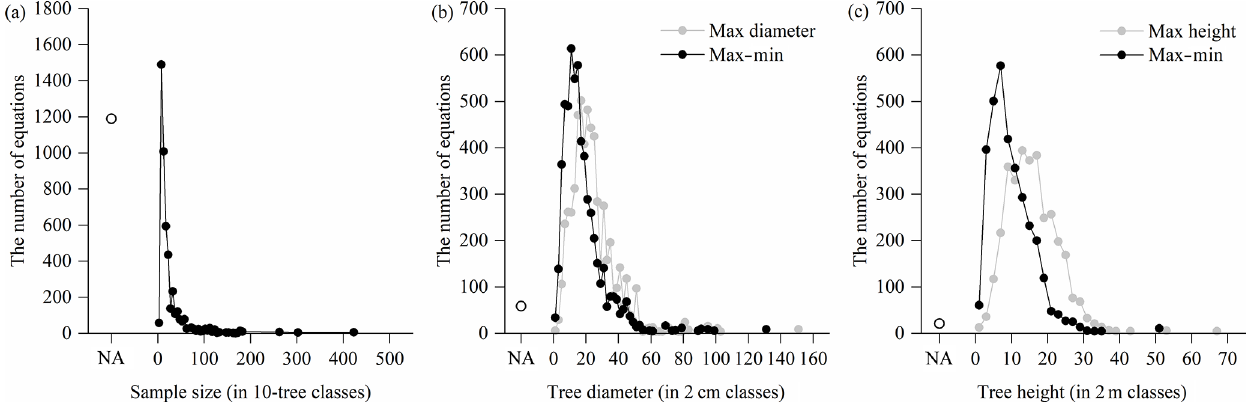
Figure 5. Distribution of sample size and applicable range of compiled biomass equations: (a) sample size, (b) tree diameter and (c) tree height. Dots represent the number of equations within each class. If sample sizes and applicable ranges are not available, they are indicated by